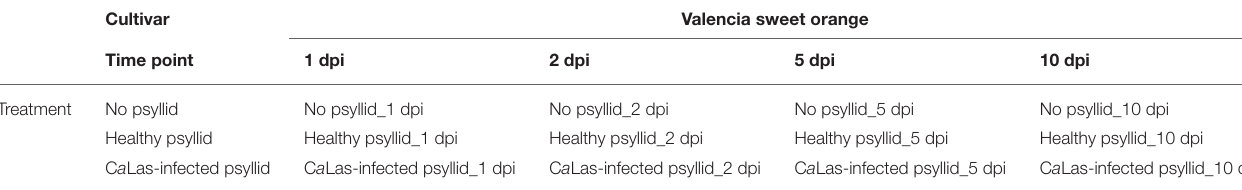
TABLE 1 | Experimental plan: cultivar, collection time, and experimental treatments. Cultivar